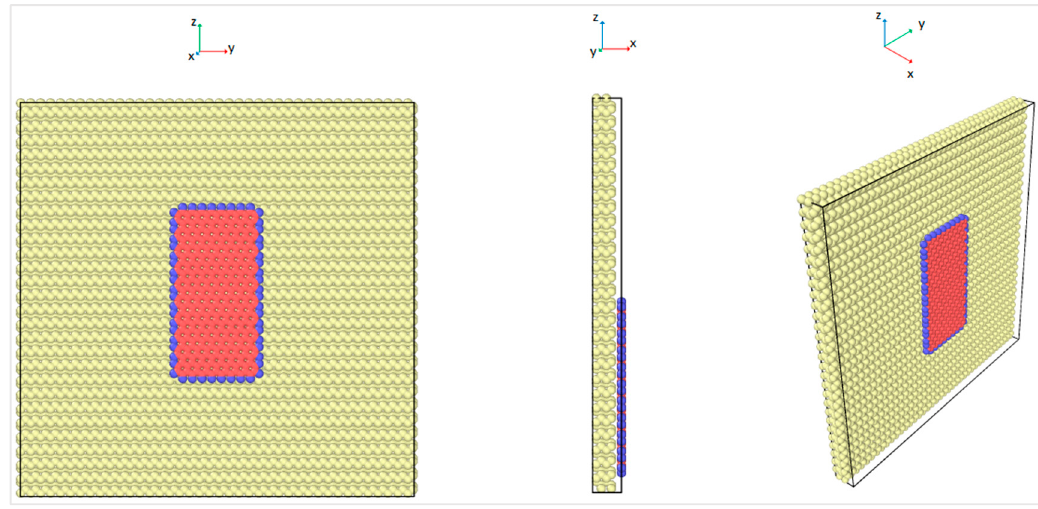
Figure 4. Geometry of the relaxation simulation.